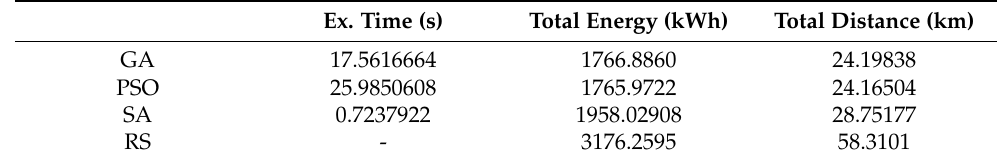
Table 5. Execution results of the case of thirty bins.